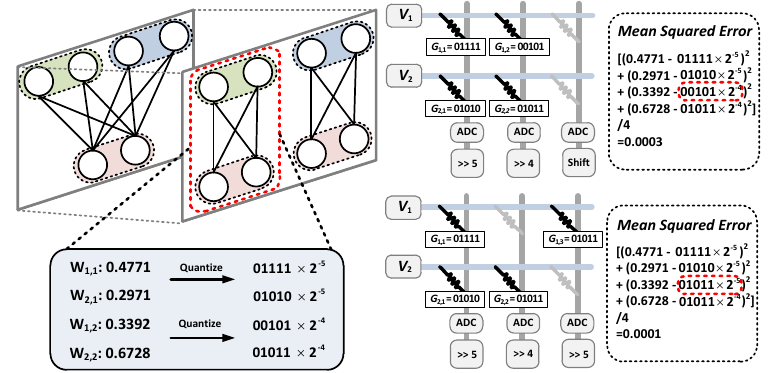
Figure 2. Smart use of extra neurons can reduce quantization error